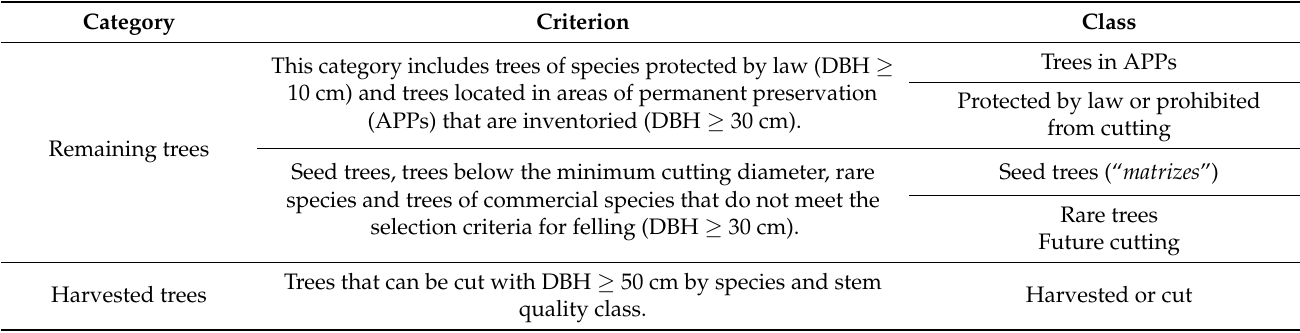
Table 1. Category and description of the criteria defining the classes established for cutting and maintenance of trees (IBAMA Standard No. 2 of 26 April 2007) [26]). Category Criterion Class